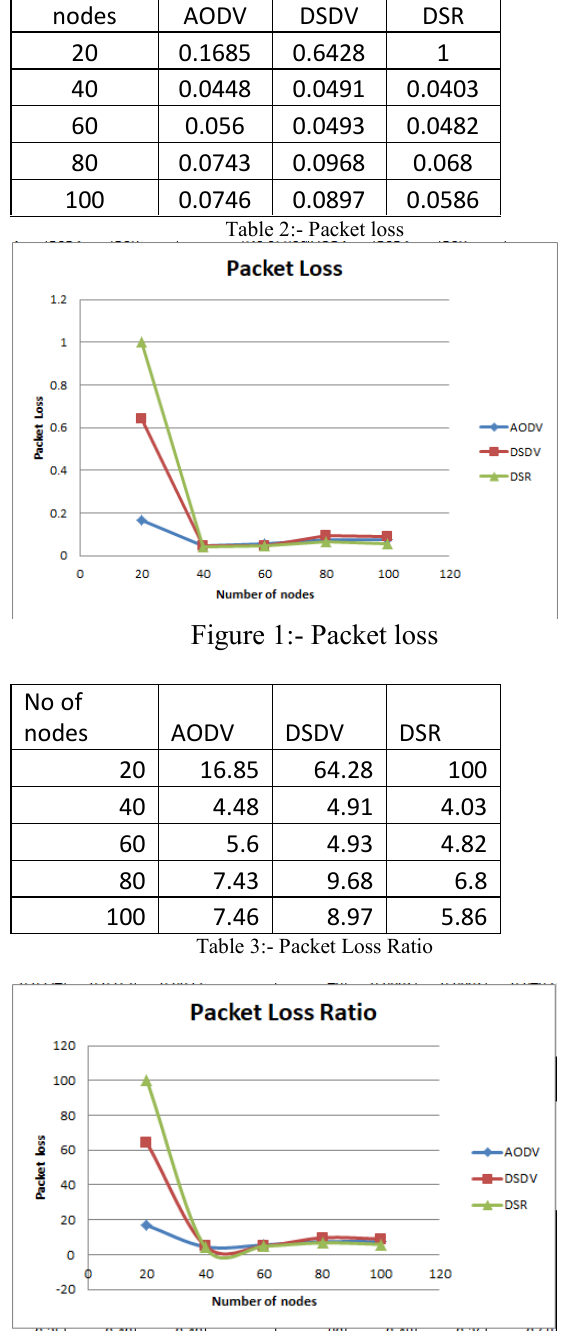
Table 2:- Packet loss